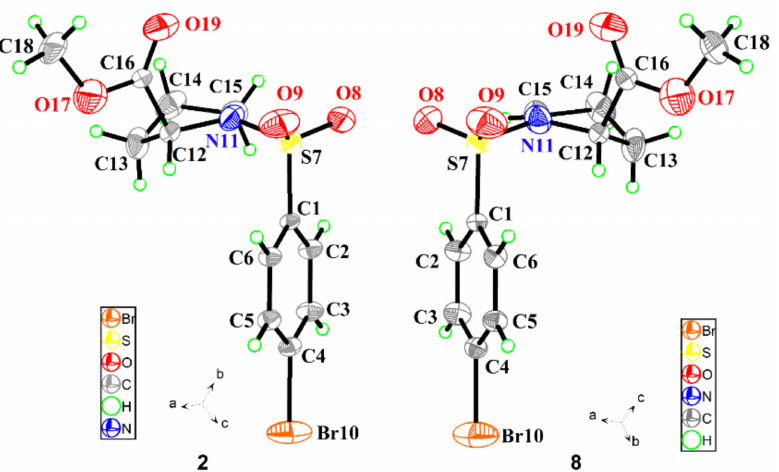
Figure 4. A perspective view of 2 and 8 , showing the atom-labelling scheme. Displacement ellipsoids are drawn at the 50% probability